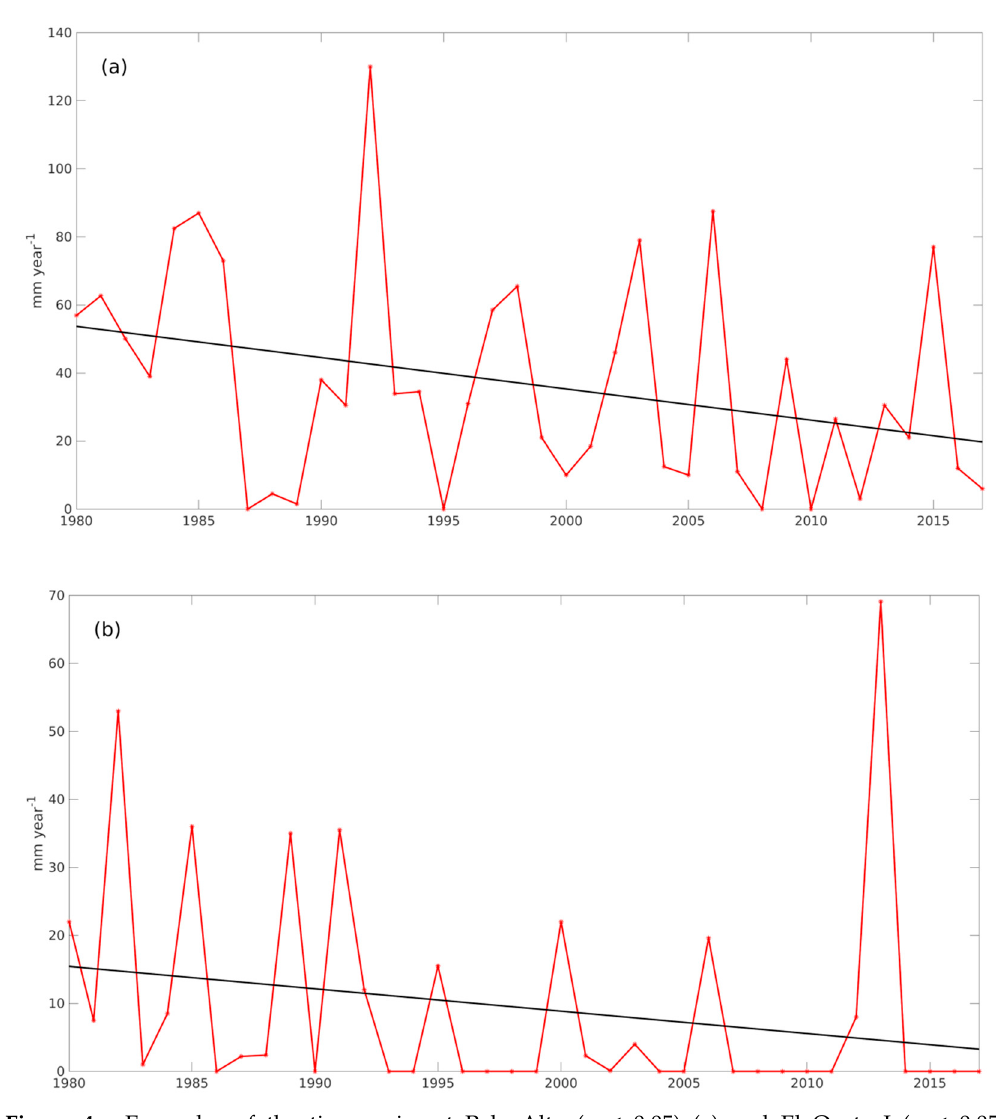
Figure 4. Examples of the time series at Palo Alto ( p ≤ 0.05) ( a ) and El Ocote I ( p ≤ 0.05) ( b ) weather stations.